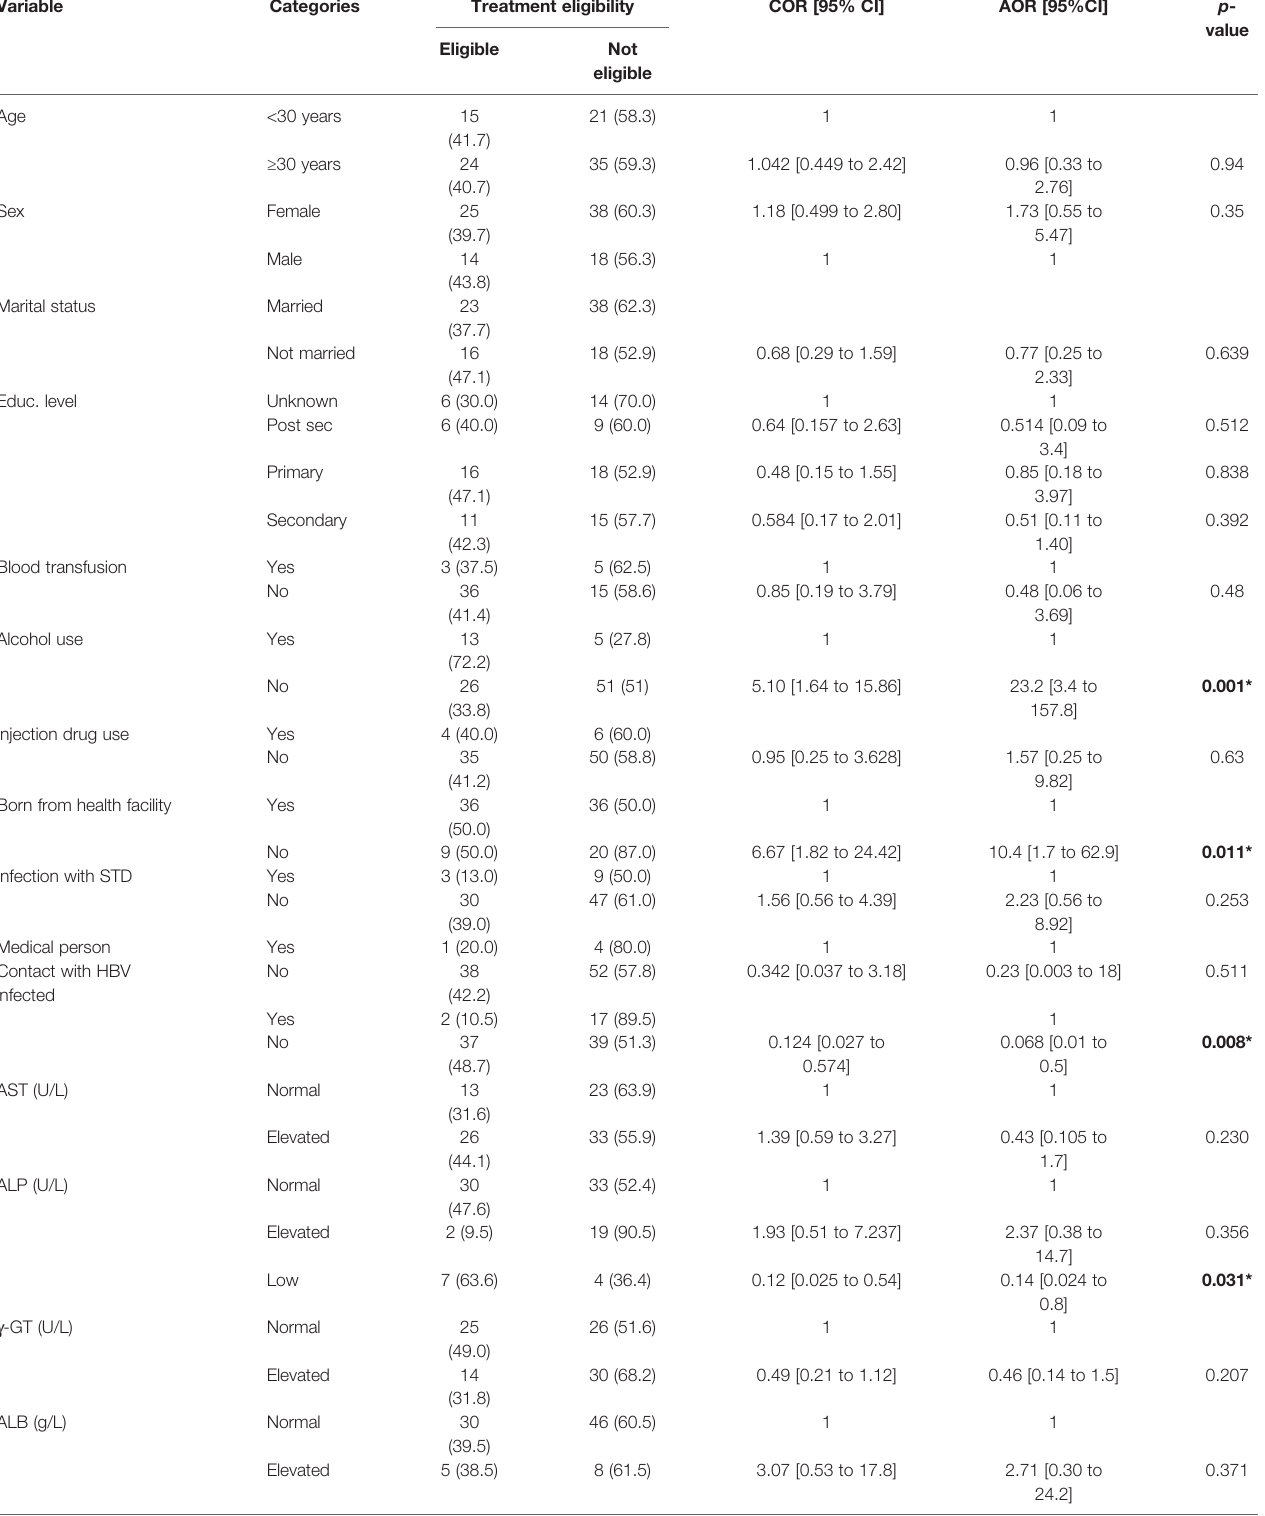
TABLE 4 | Socio-demographic factors and liver function tests associated with treatment eligibility among the HBsAg seropositive participants from the high endemic region.